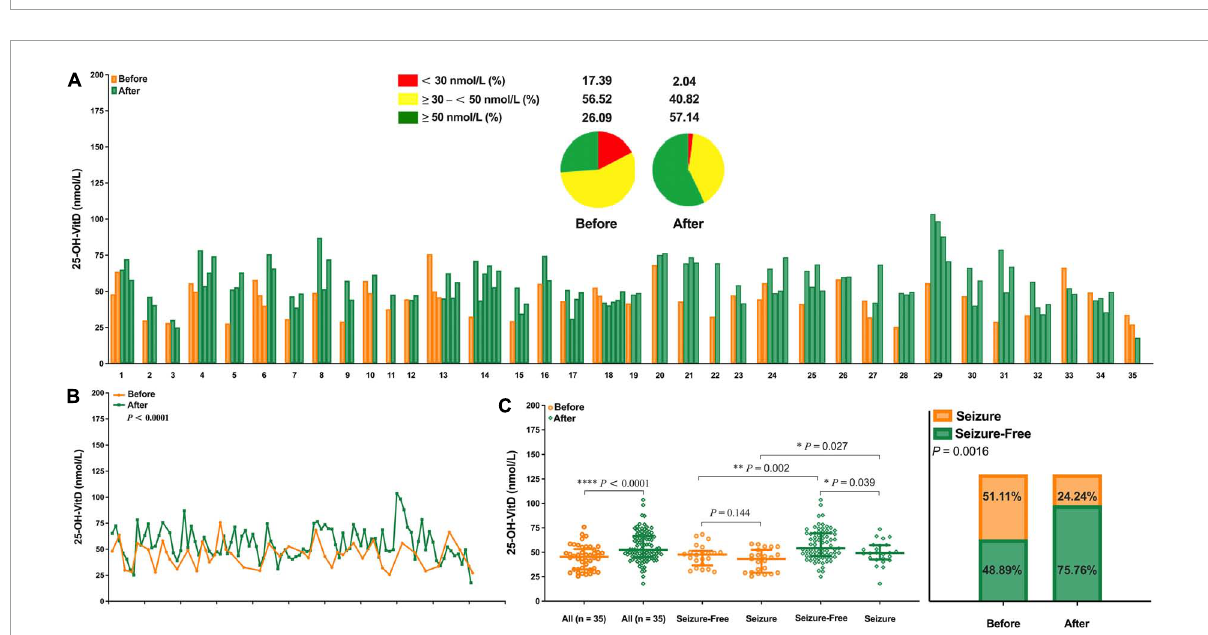
FIGURE10 Comparison in serum 25-OH-VitD status of children with epilepsy before and after vitamin D supplementation. (A) 25-OH-VitD status of 35 children with epilepsy before and after vitamin D supplementation and proportion of 25-OH-VitD sufficiency, insufficiency and deficiency before and after vitamin D supplementation. (B) Overall comparison in serum 25-OH-VitD status of 35 children with epilepsy before and after vitamin D supplementation. (C) Comparison in serum 25-OH-VitD status of 35 patients before and after vitamin D supplementation and with different seizure outcomes. (D) Proportion of children with epilepsy seizure and seizure free before and after vitamin D supplementation.